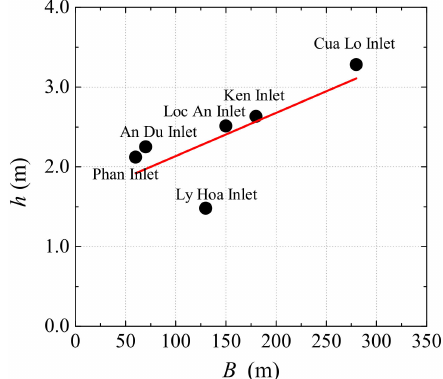
Figure 17. Relationship between the sand spit width and tidal inlet